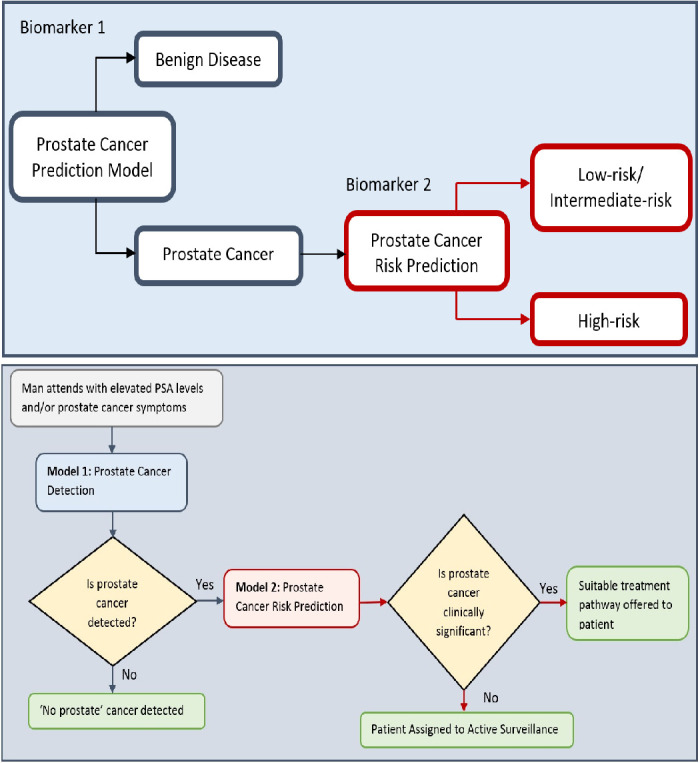
Flow charts illustrating the process to detect the presence and risk of prostate cancer and patient outcomes.Model 1: Distinguishes between men with benign prostate disease and prostate cancer; Model 2: predicts risk (in terms of clinical significance) in men identified as having prostate cancer in Stage 1. Note that Model 1 can detect prostate cancer in men with PSA < 20 ng ml-1.